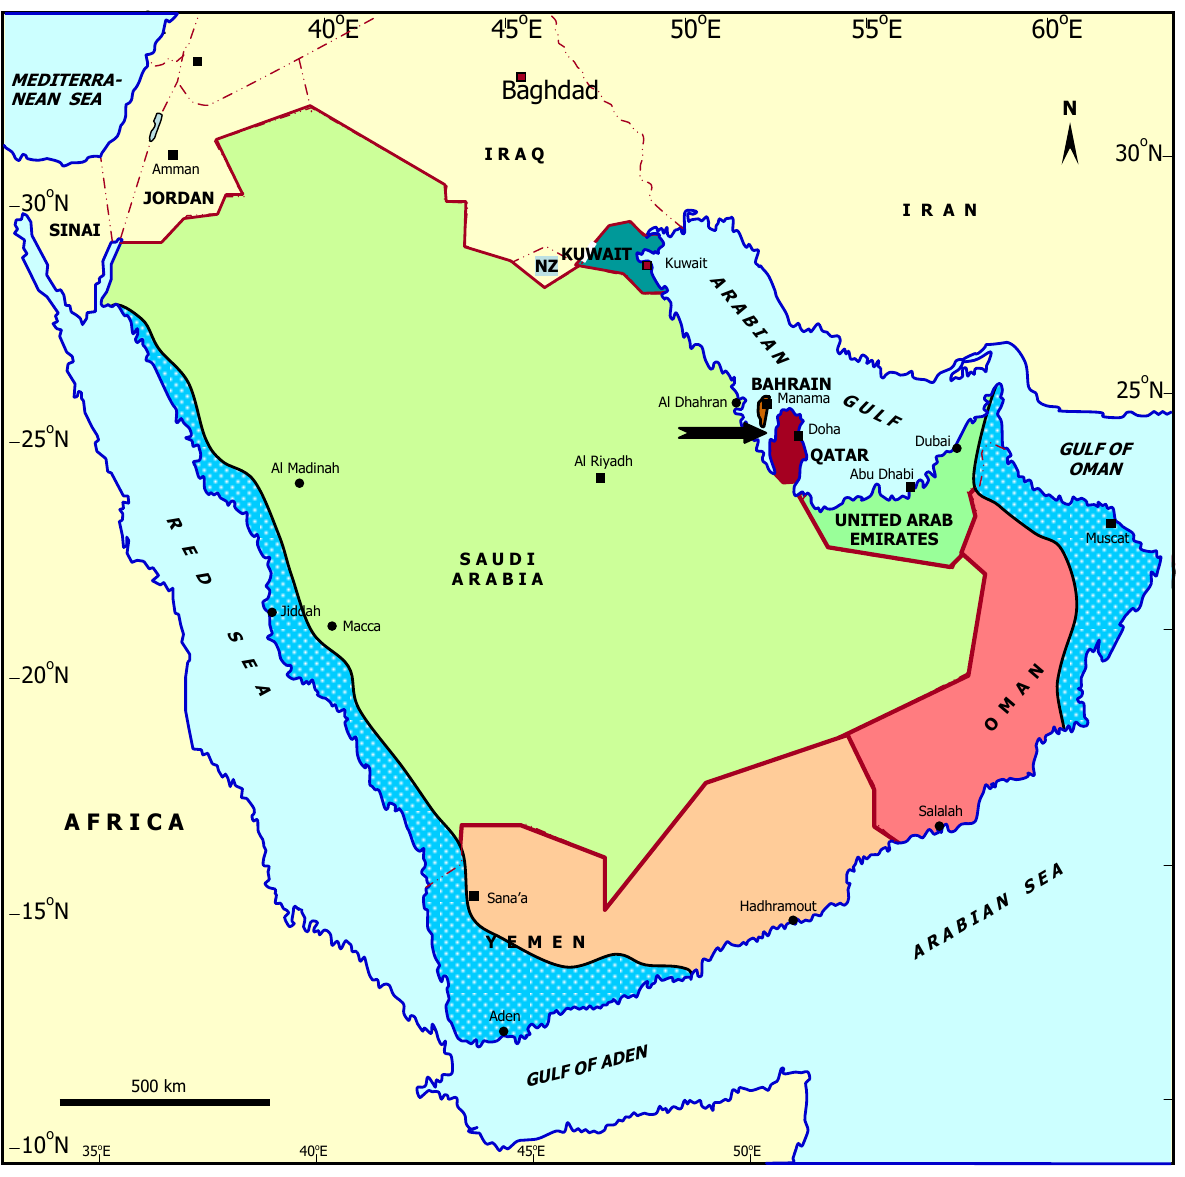
Figure 1. Locator map of Qatar and surrounding